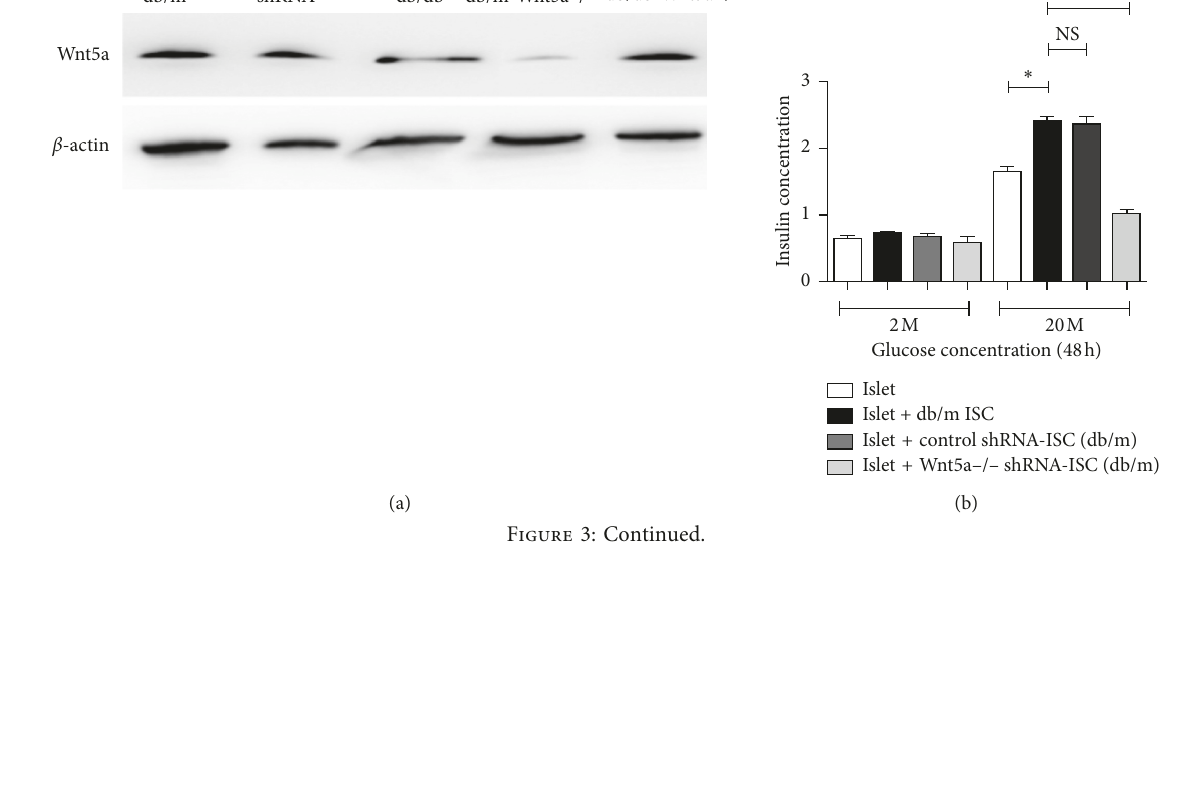
db/m shRNA db/db db/m-Wnt5a–/–